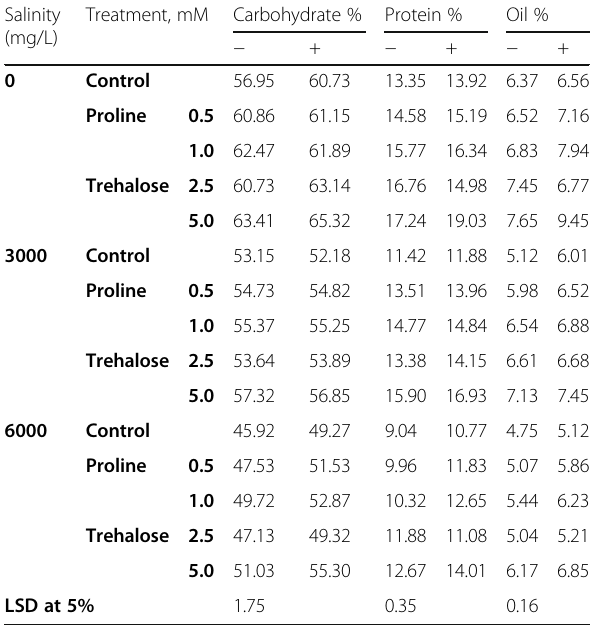
Table 9 Element contents N, P, and K (%) in the yielded seeds of quinoa plants treated with proline or trehalose with (+) and without ( − ) compost amendment under salinity stress (average of two seasons) Salinity